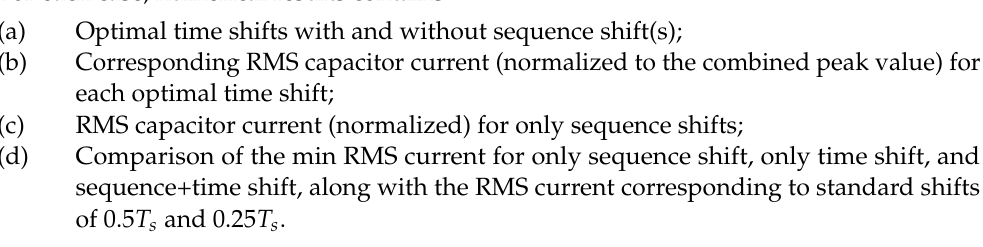
Comparison of the min RMS current for only sequence shift, only time shift, and sequence+time shift, along with the RMS current corresponding to standard shifts of 0.5 T s and 0.25 T s